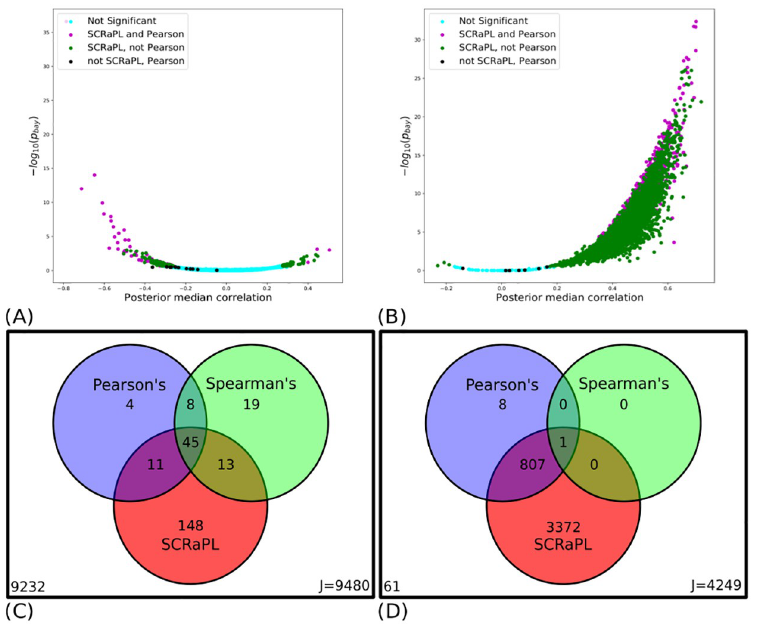
Fig 3. Summary of experiments on real data. Figures summarizing most important points from synthetic and real data experiments. (3A, 3B) Bayesian volcano plots for mESC and mEBC data respectively. Scatter plot of posterior probability under the null hypothesis (in log scale) as a function of posterior median correlation. Each dot represents a feature and is marked with different color depending the method that labels it as a significant association. (3C, 3D) Venn diagrams summarizing detection rates for SCRaPL, Pearson and Spearman in mESC and mEBC data. By accounting for different sources of noise it detects a large set of features identified by frequentist alternatives. SCRaPL also uncovers a additional large set that would be impossible for frequentist methods to identify in a robust